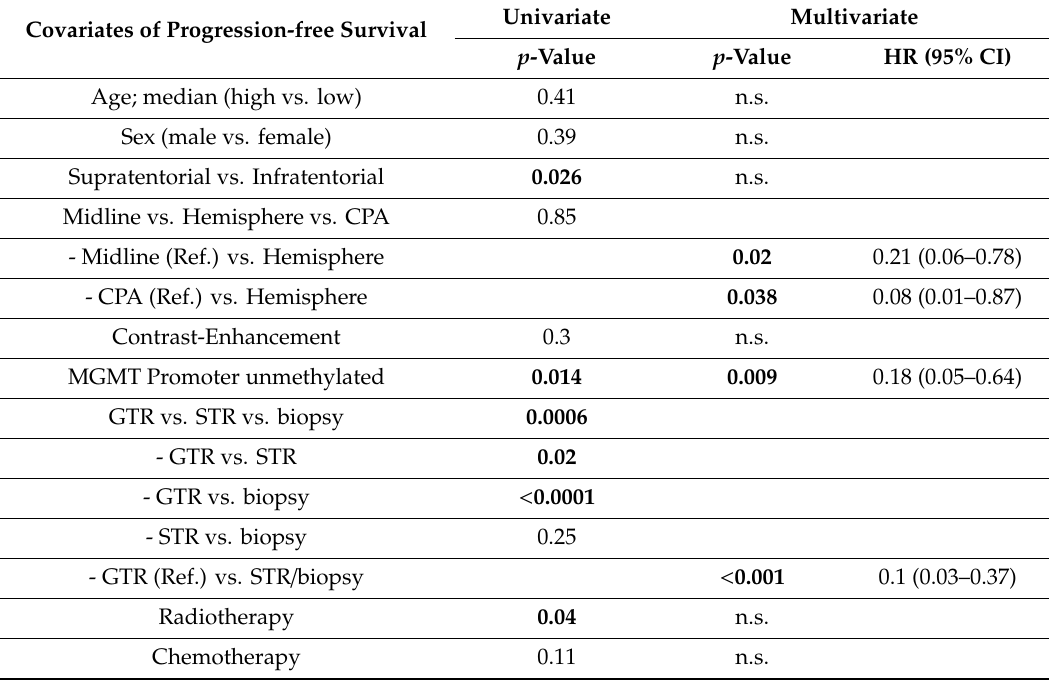
Radiotherapy 0.04